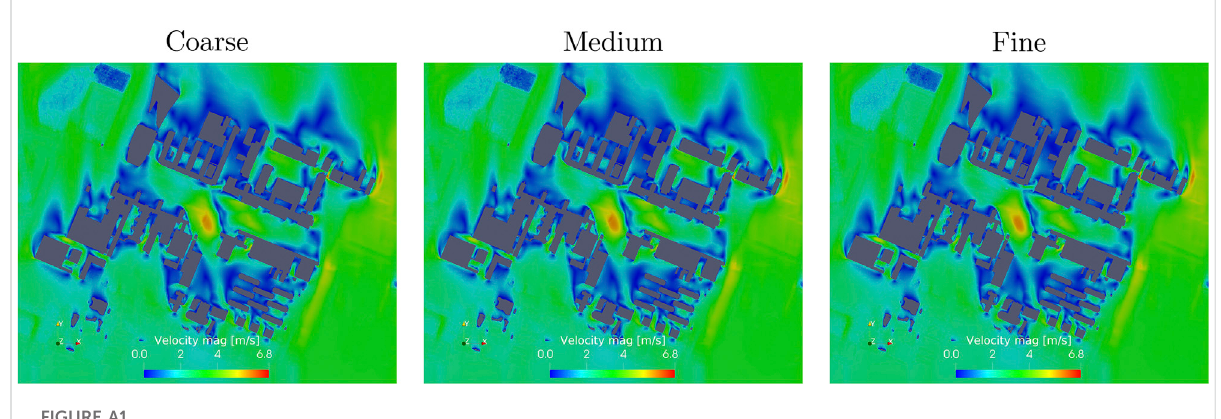
FIGURE A1 Velocity magnitude fi elds for all three investigated meshes.